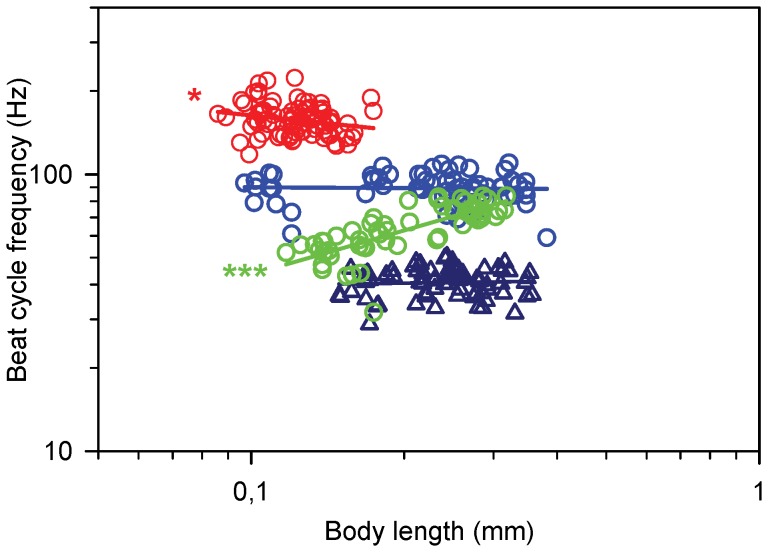
Beat cycle frequency (BCF) as function of body length (BL) in nauplii.Regression lines are power laws fitted to the data. Blue circles, T. longicornis (slope  = −0.01, p = 0.53, n = 63); red circles, O. davisae: Log(BCF) = −0.19Log(BL) +2.02 (r2 = 0.05, p = 0.046, n = 82); green circles, A. tonsa: Log(BCF)  = 0.53Log(BL) +2.17 (r2 = 0.57, p<0.0001, n = 59); blue triangles, swimming T. longicornis (slope  = 0.03, p = 0.89, n = 71).